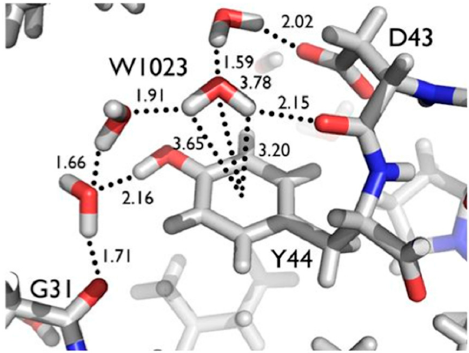
Figure 7. Crambin residue Tyr44 is making van der Waals contact with Ile33 on one side of the aromatic ring and is solvated on the other side. W1023 interacts with the π -system of residue Tyr44. D1 of W1023 is directly pointing Gly31 and different degrees of H/D exchange. Figure reproduced from [20].